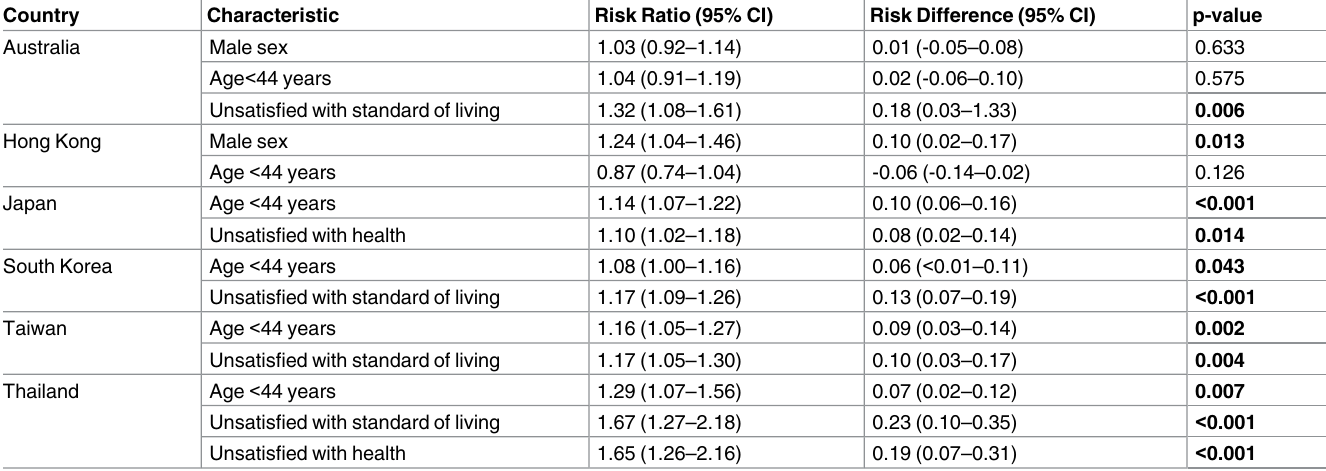
Table 3. Multivariate regression models for lower trust (trust ‘not at all’ or ‘not much’) in Political Leaders in each country.